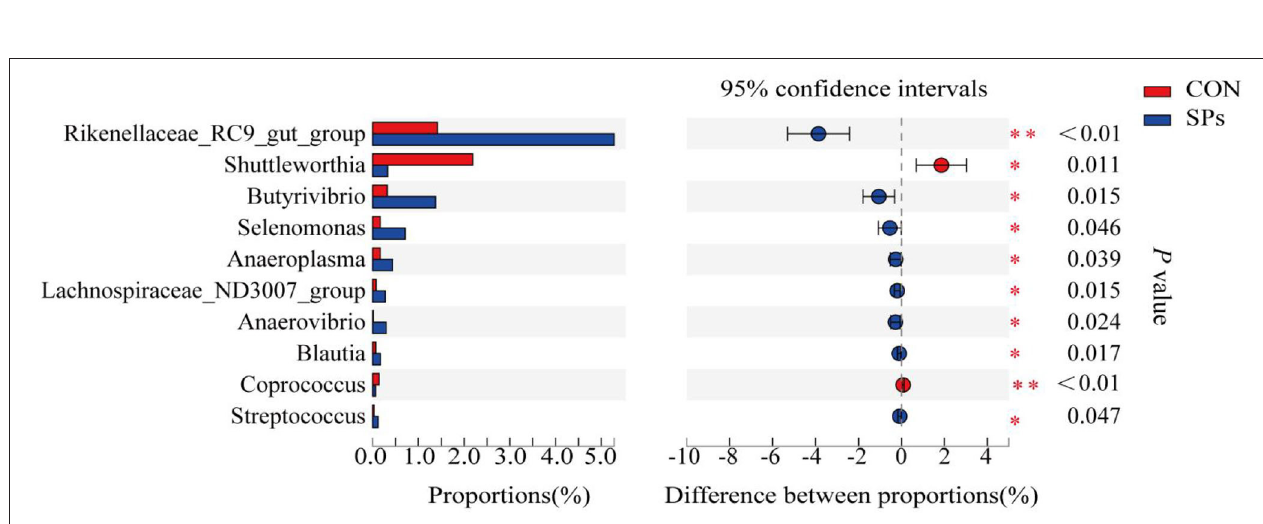
FIGURE 4 | Effects of the dietary supplementation of soybean peptides (SPs) on the composition of (A) phyla and (B) genera of bacterial communities in CON and SPs groups. CON, the control group with no soybean peptide supplementation; SPs, the group with 50 g/head/day of soybean peptide supplementation.